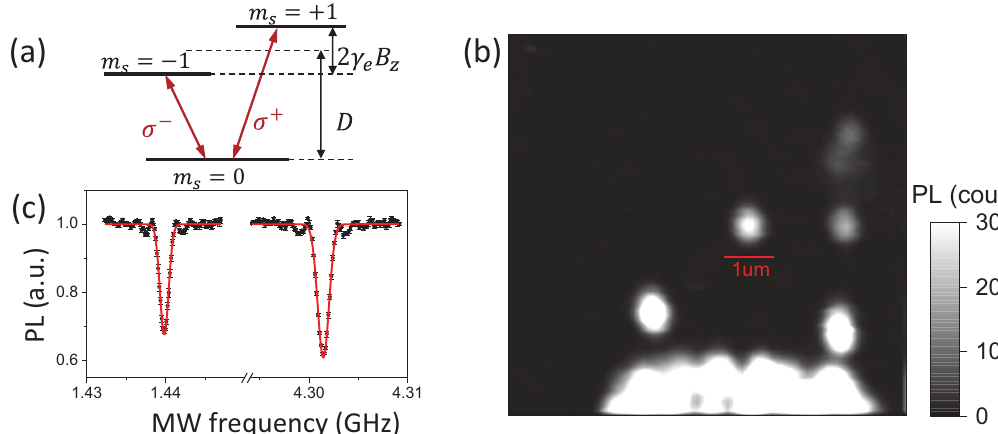
Figure 2. ( a ) The ground electron spin triplet state of the NV center with zero field splitting of D = 2.87 GHz between the m s = 0 state and m s = ± 1 state. A magnetic field of B z along the direction of the NV axis leads to an energy level splitting of 2 γ e B z , where γ e = 2.8 MHz/G is the gyro-magnetic ratio of NV electron spin. The spin transition m s = 0 ↔ m s = − 1 (+ 1 ) can be selectively addressed by the σ − ( σ + ) polarized MW field. ( b ) Scanning picture of a diamond sample containing a single NV center. The marked bright spot is the single NV center used for MW field detection in this experiment. The other bright signals below are from ensemble NV centers. ( c ) Optically-detected magnetic resonance spectra of nitrogen vacancy (NV) center under a bias magnetic field of about 500 G. The data are fitted with the Gauss function. The first (second) dip at f 1 = 1.44 GHz ( f 2 = 4.30 GHz) corresponds to the transition m s = 0 ↔ m s = − 1 (+ 1 )